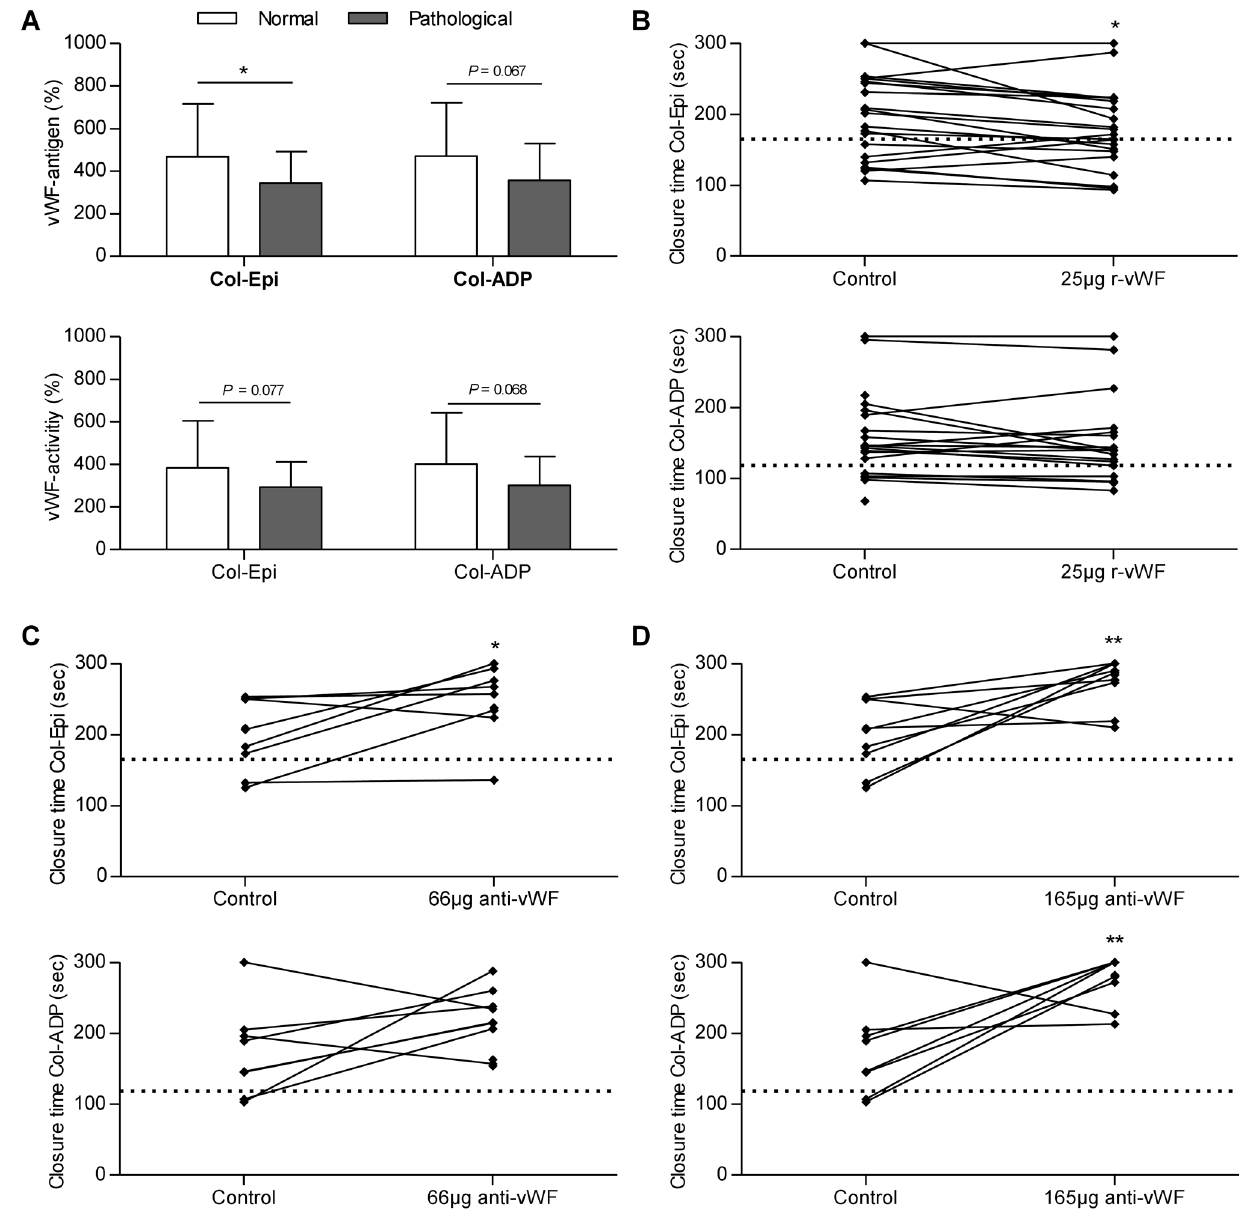
Figure 3. Effect of von Willebrand factor on primary hemostasis in thrombocytopenic patients with liver cirrhosis. Increased levels of vWF were associated with maintained normal primary hemostasis in patients with liver cirrhosis and reduced platelet count ( , 150/nL). vWF-antigen and vWF-activity were higher in patients with normal results for PFA-100 after measuring with Col-Epi and Col-ADP (A + B). Substitution of recombinant vWF (r-vWF) resulted in improved primary hemostasis as compared to unmodified samples (C). Addition of a 66- m g or 165- m g polyclonal anti-vWF-antibody levels led to prolonged closure times compared to unmodified control samples (D + E). Horizontal lines represent the upper limit of normal for closure times with Col-Epi or Col-ADP [**: P , 0.01, *: P , 0.05].